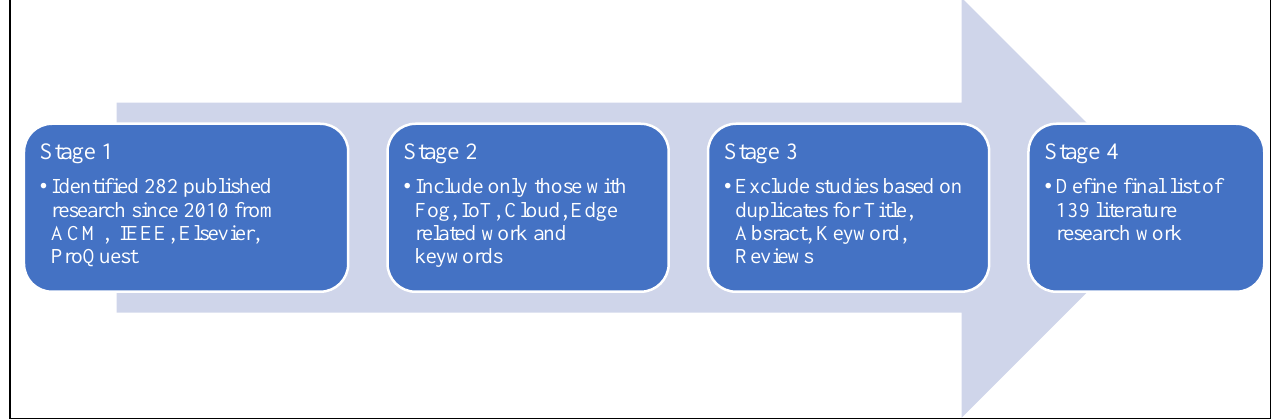
Figure 1. Four Stage Selection Criteria